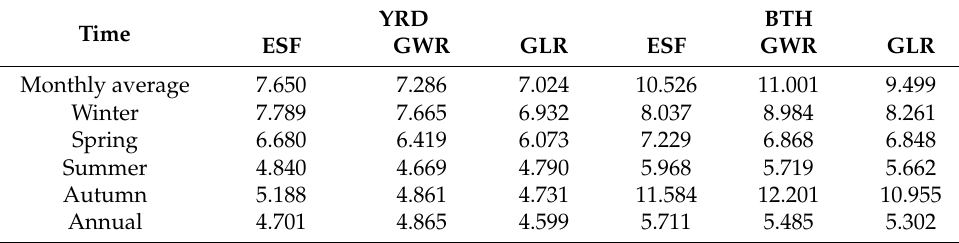
Table 5. The 10-fold CV RMSE of models at monthly, seasonal, and annual time scales. YRD Time